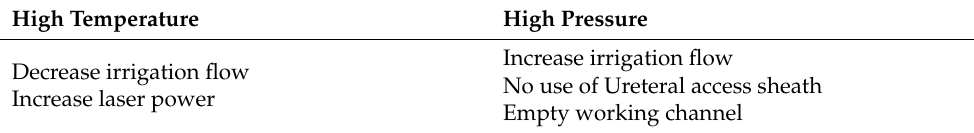
Table 2. Determinants of high temperature and pressure.